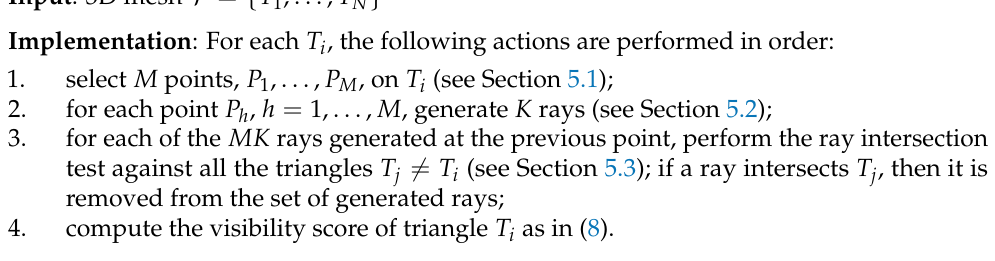
Algorithm 1 VSD based on Plücker